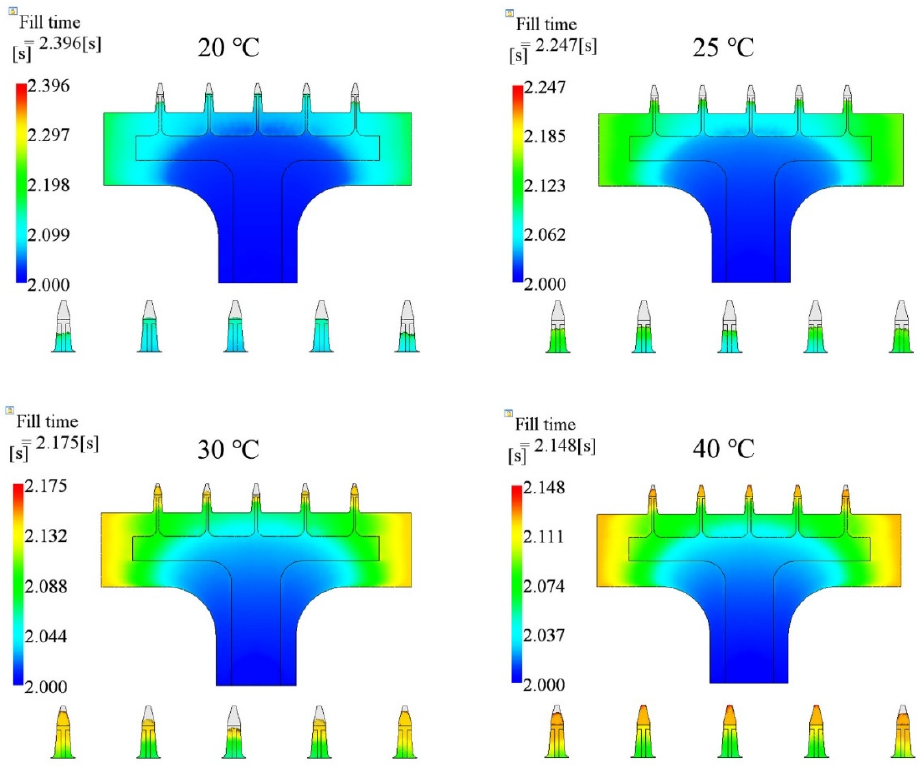
Figure 8. Filling contours for different mold temperature cases.